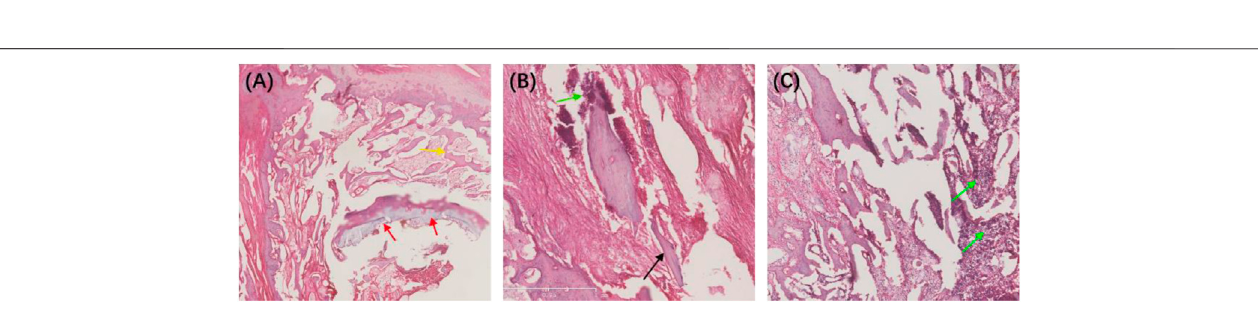
FIGURE11| HE-stainedsectionsofthechronic-osteomyelitis-mode.Treatmentgroup (A) ,controlgroup (B) andblankgroup (C) after28 daysoftreatments.Red arrow, new bone; yellow arrow, trabecular bone; black arrow, dead bone; green arrow, in fl ammatory cells.